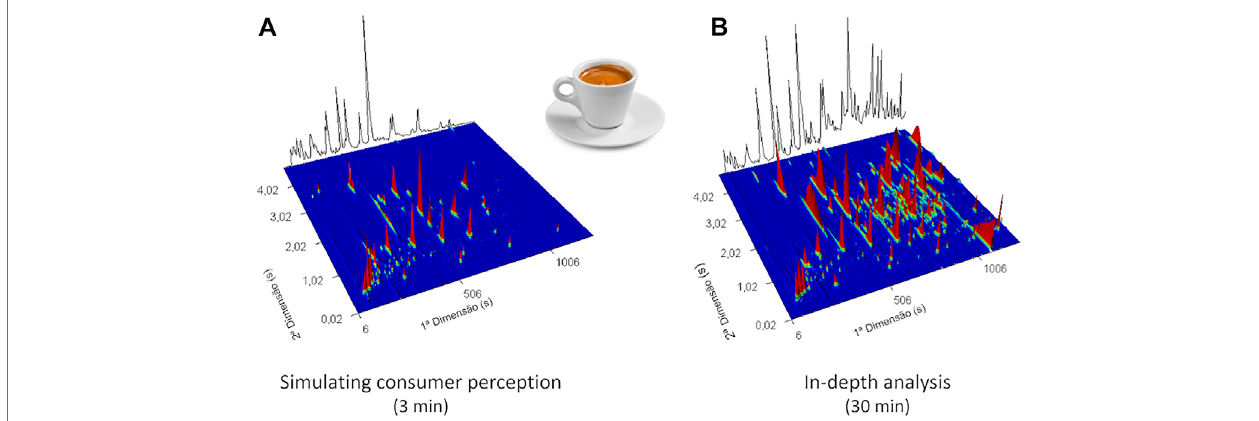
FIGURE 5 | 3D GC × GC total ion chromatogram plot of (A) espresso using 3 min of SPME extraction time to simulate the consumption conditions of this product and (B) with 30 min of SPME extraction time for an in-depth characterization of volatile components (using a DVB/CAR/PDMS coating fi ber, at 55 ° C of extraction